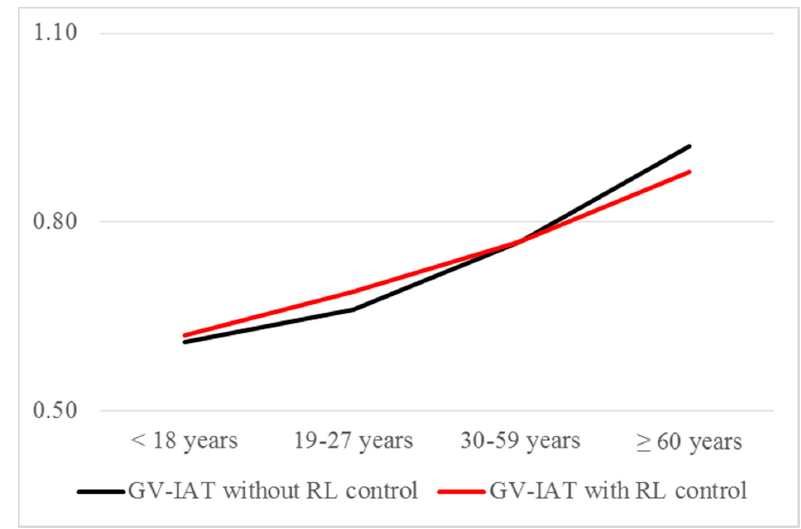
Figure 3. GV-IAT effects with and without RL control. Figure 3. GV-IAT e ff ects with and without RL control.